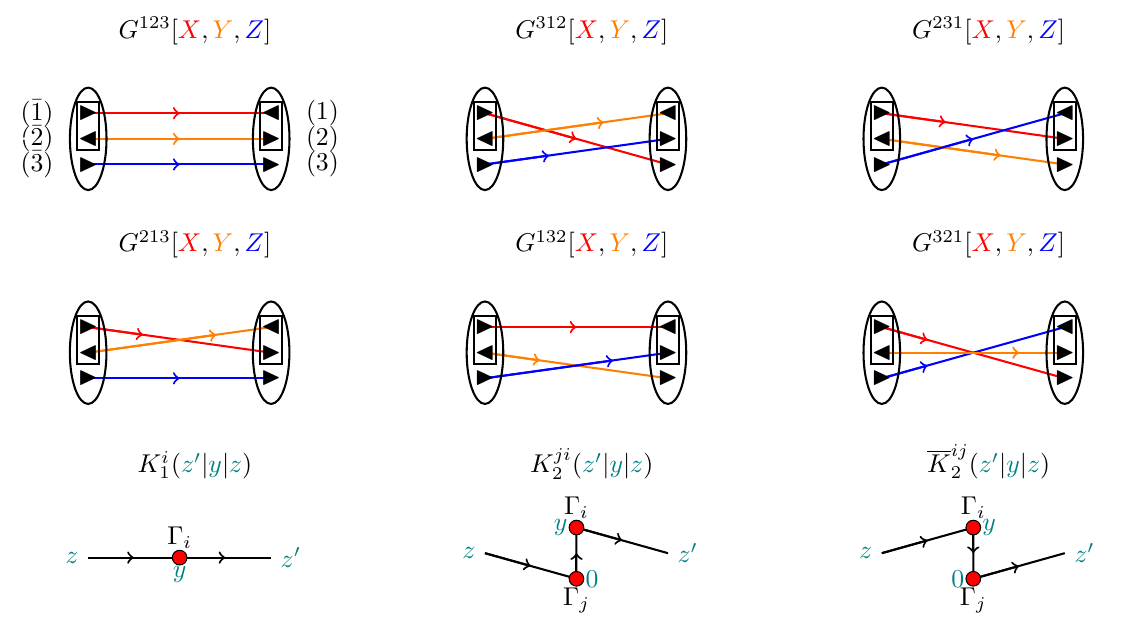
Figure 30 . Depiction of expressions (A.4) and (A.6) used for the construction of each baryonic four-point function graph. The blobs at the left (right) of each graph in the two first lines denote the baryon source (sink). Each symbol I and J represents a quark field, where J means that the corresponding spinor has to be transposed. The boxes denote the di-quark. For the three quark line types (bottom) we also indicate the positions of the propagator end points and the indices of the current